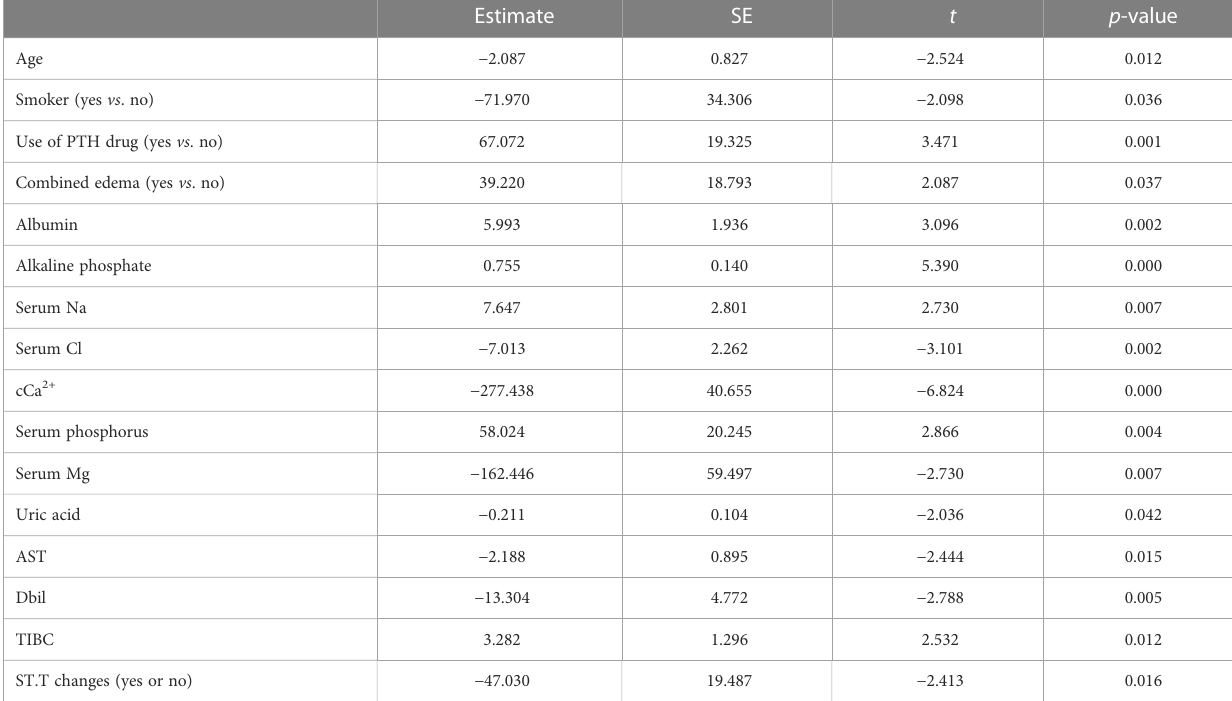
TABLE 4 Multivariate linear regression of the intact parathyroid hormone (iPTH) levels with clinical parameters. Estimate SE